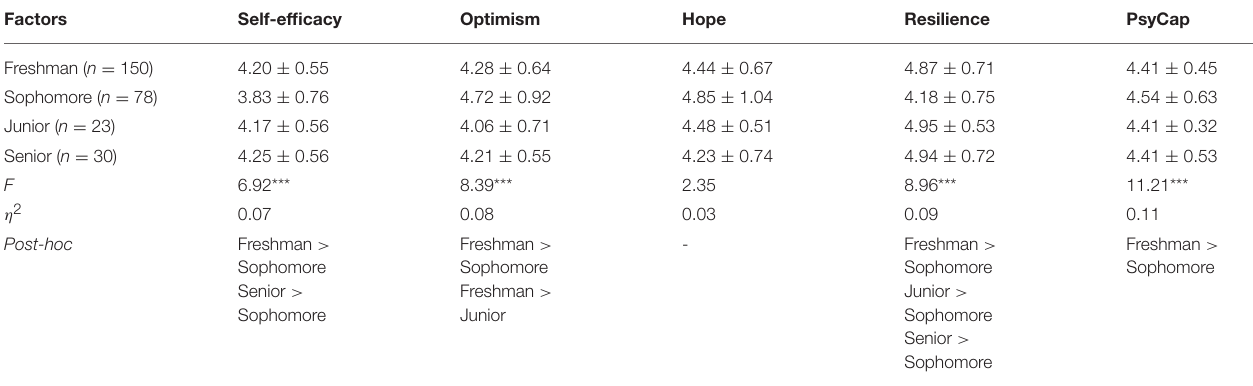
TABLE 3 | Comparison on PsyCap results of USWL in different grades factors.